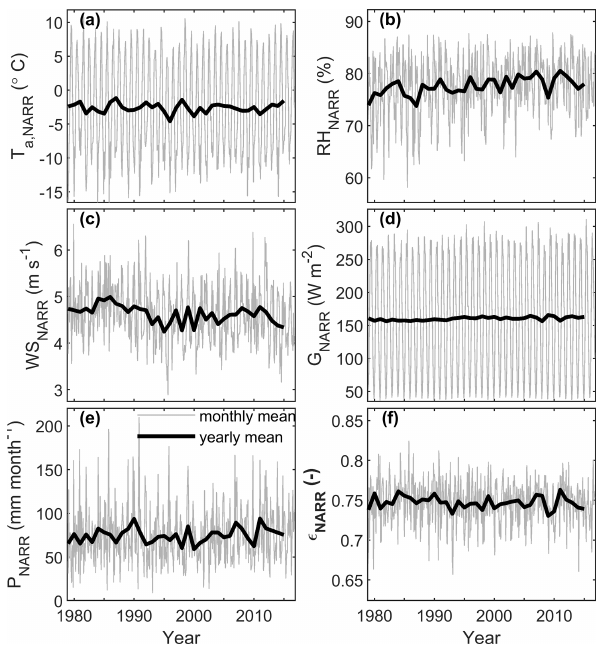
Figure 4. Downscaled NARR variables from the nearest NARR grid cell used to drive the DEBAM model. Grey solid lines rep- resent monthly means, and black solid lines represent annual av- erages. (a) Air temperature; (b) relative humidity; (c) wind speed; (d) incoming global solar radiation; (e) total precipitation; (f) atmo- spheric